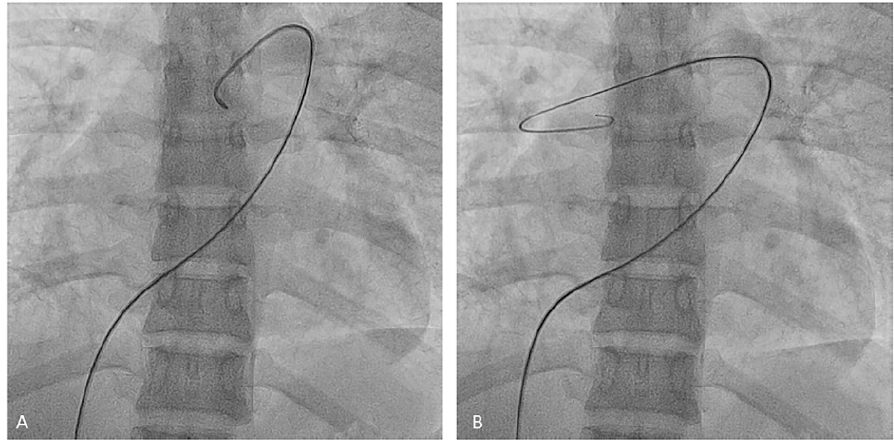
Figure 27. Steps to canulate the right pulmonary artery, ( A ) first step, ( B ) second step.